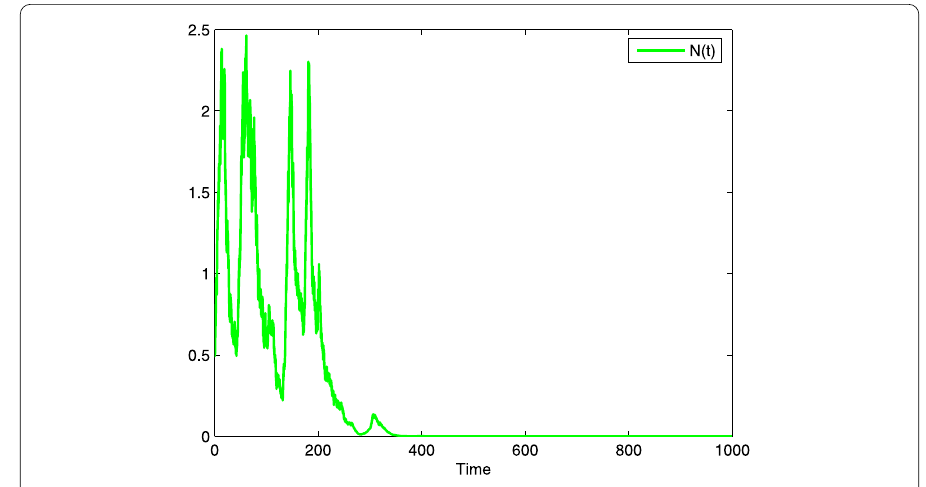
Figure 3 A trajectory of hybrid system (3) with parameter values given in Fig. 1 and Fig. 2, and φ = (0.8,0.2). This figure suggests that the species represented by hybrid system (3) vanishes